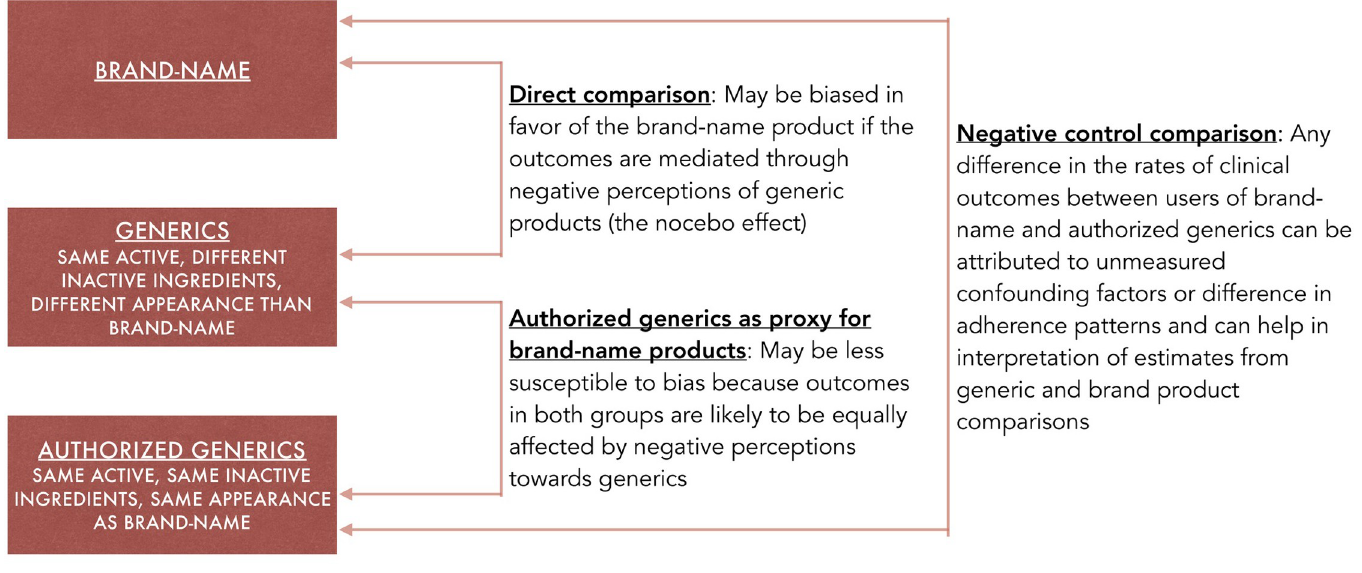
2 sets of analyses to compare outcomes between users of generics and brand-name products.